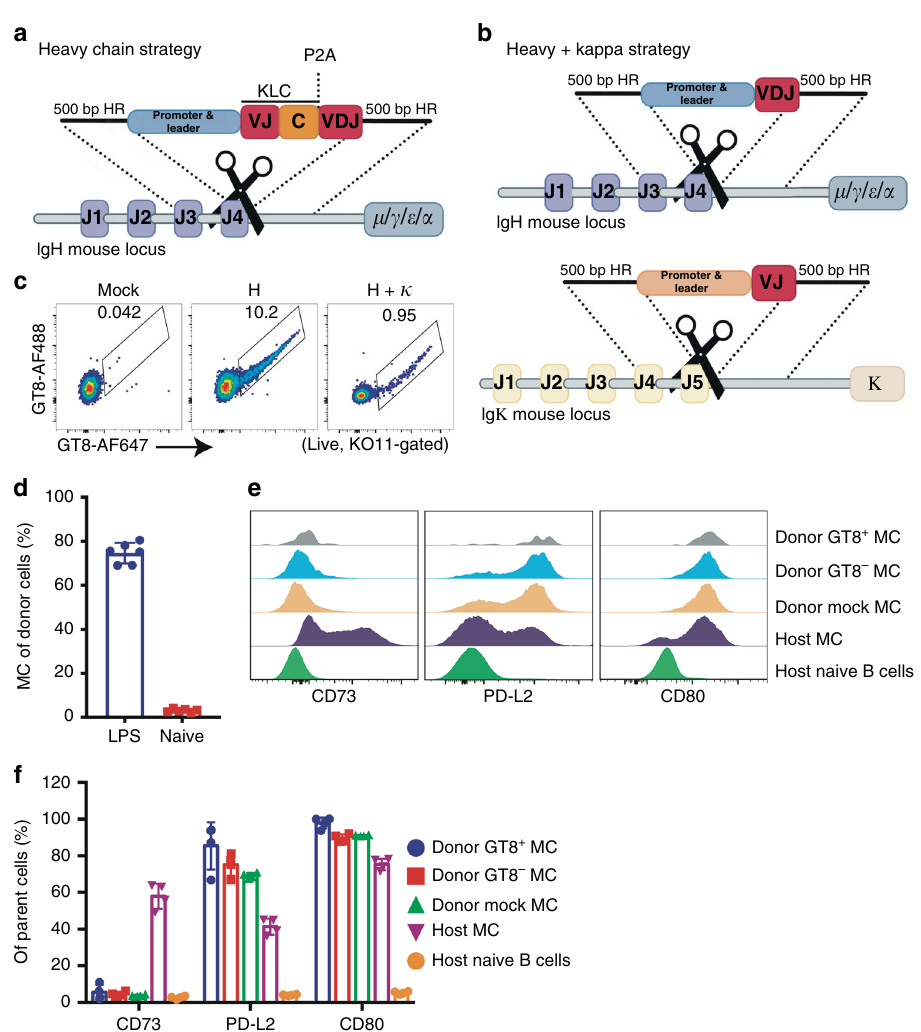
Fig. 1 Engineering primary B cells and adoptive transfer of cells to WT mice. a Targeting antibody genes to the mouse heavy chain (HC) locus (